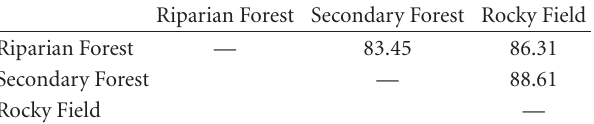
Table 3: Dissimilarity values (SIMPER) between the three phyto- physiognomies sampled in the Parque Estadual do Ibitipoca, Brazil. July–December, 2008.